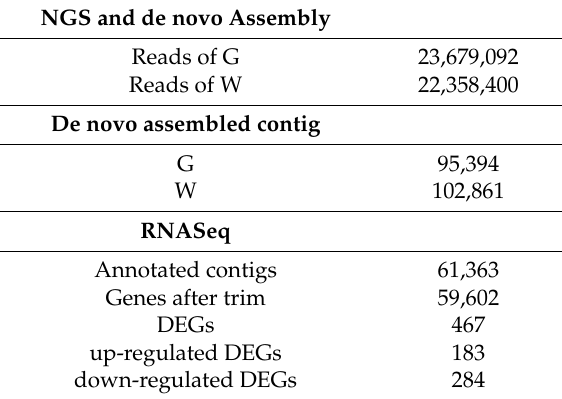
Table 1. Results of Next Generation Sequencing (NGS), RNAseq and DEG analysis in green (G) and